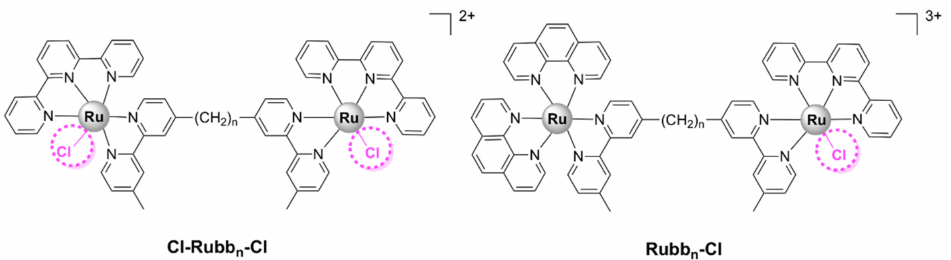
Figure 14. Chemical structures of labile dinuclear Cl-Rubb n -Cl and Rubb n -Cl complexes, where n = 7, 12,